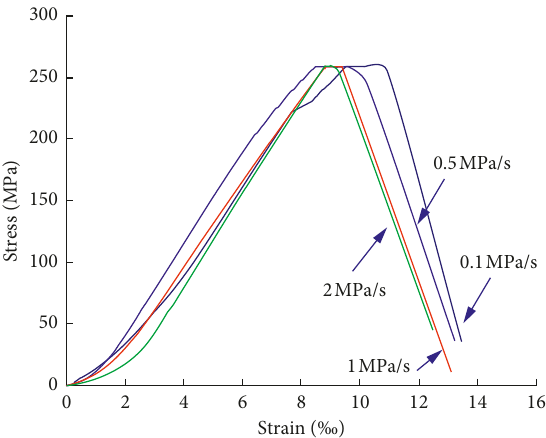
Figure 22: The axial stress-strain curve of the tested specimen under different support failure